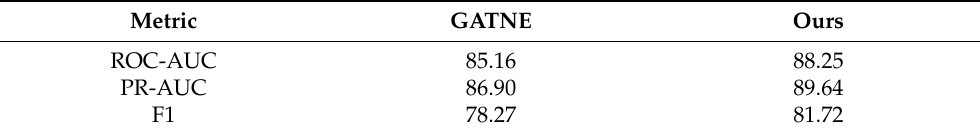
Table 4. Effect comparison of cold-start